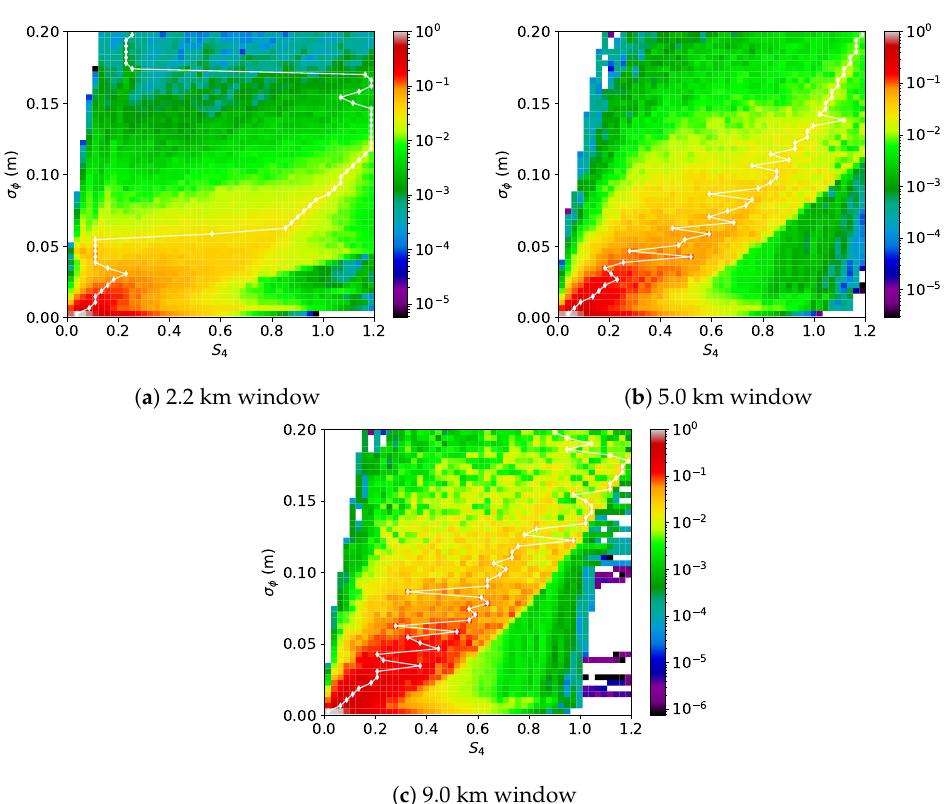
Figure 11. Same as Figure 6 but with the exclusion of layers with φ 0 / r 2